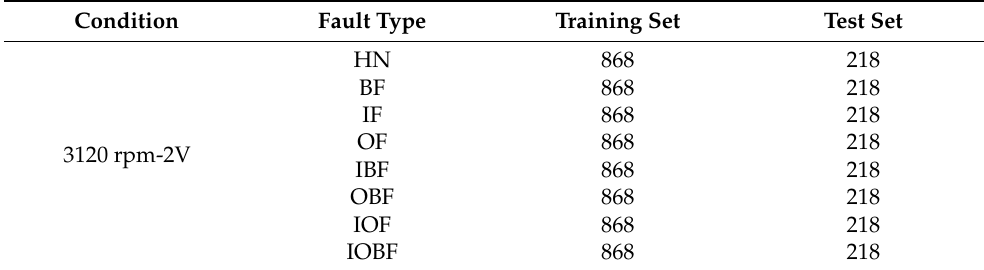
Table 1. Details of the rolling bearing datasets.